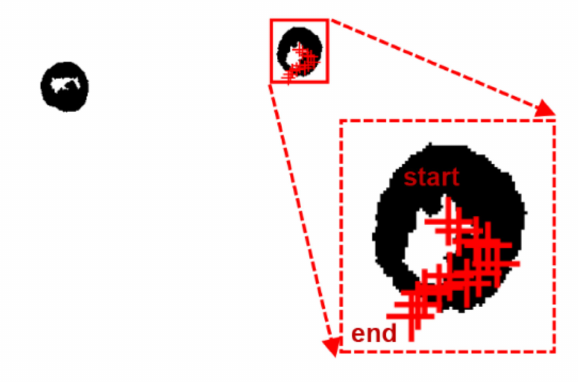
Figure 12. Motion trajectory of the cell of